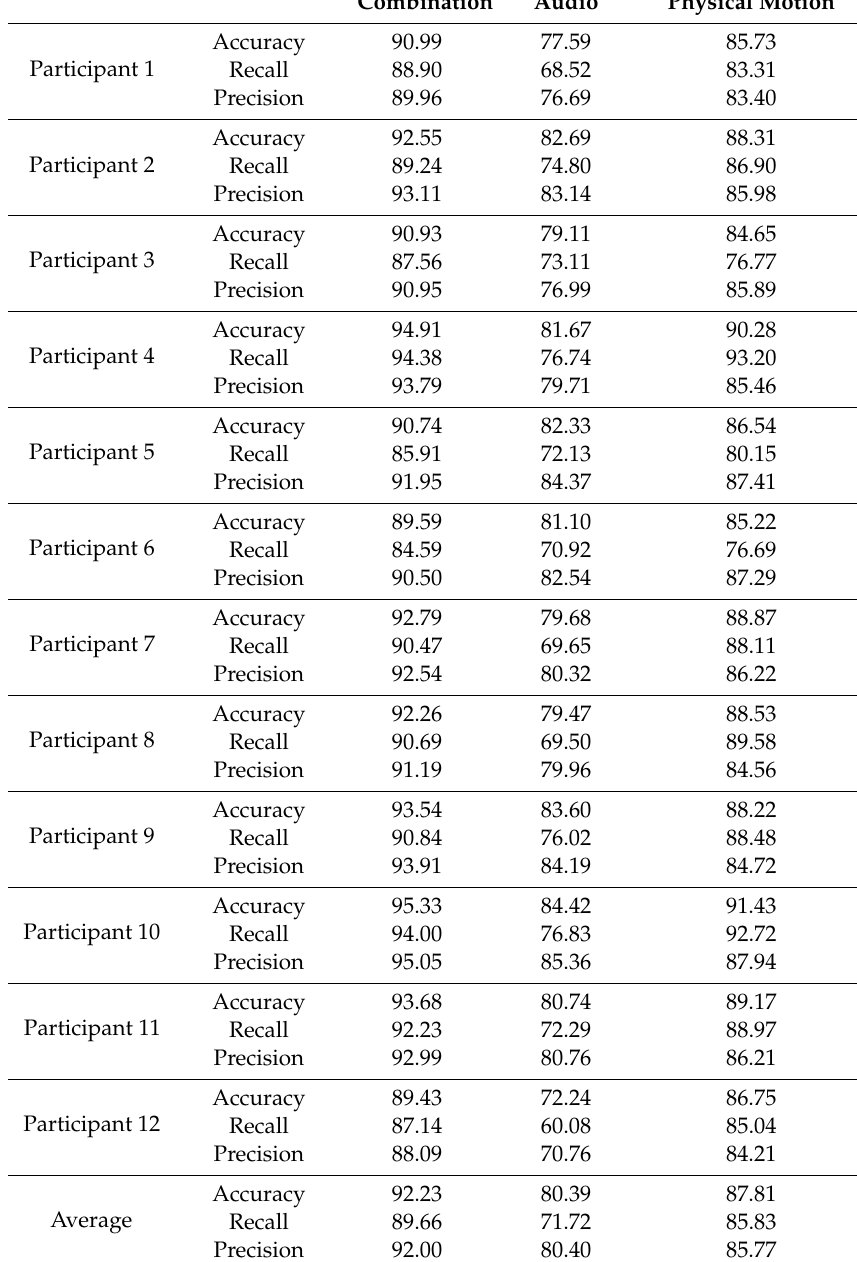
Table 4. Performance of intra-individual classification (%) using multimodal (combination of audio and physical motion) and unimodal